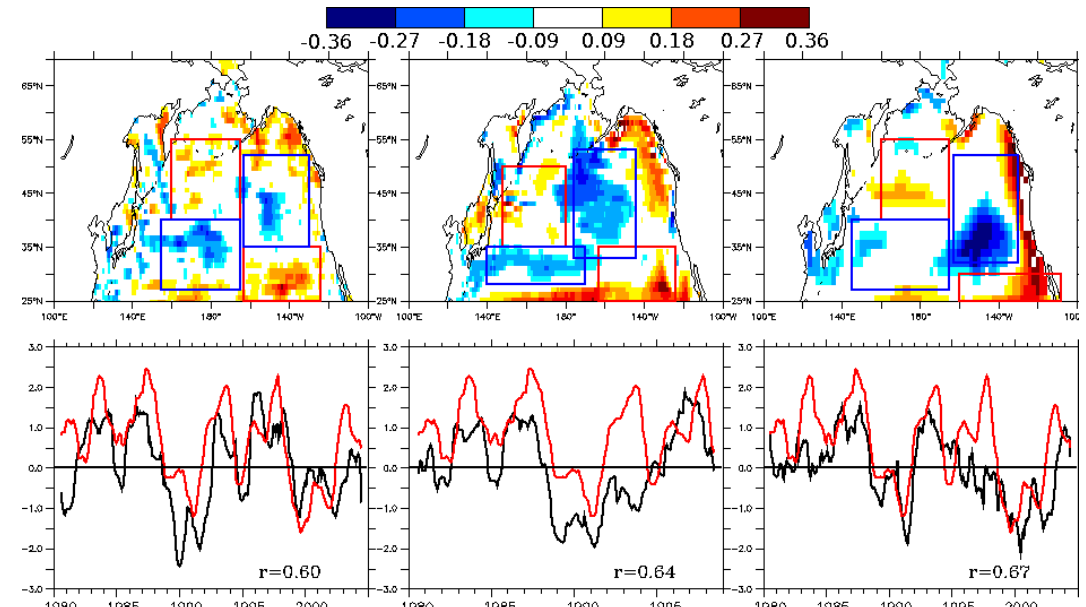
Fig. 4. (Top panels): Correlation coefficients ( r ) between the interannual variability of net air-to-sea CO 2 flux (computed as monthly anomalies of CO 2 flux) and the PDO index from three data products; (left) assimilation, (middle) McKinley et al., 2004 and (right) Le Qu´er´e et al., 2005. Sign convention of CO 2 flux is same as in Fig. 2. Significant correlations at 90% confidence intervals are shaded. (Bottom panels): CO 2 flux index corresponding to PDO from the three data products (black lines) and the PDO index (red lines). See text for the calculation of CO 2 flux indices. All lines are smoothed by 12-month running mean and normalized by respective standard deviations to fit into a common y-axis. The “r” of bottom panels is significant at a 95% confidence interval.